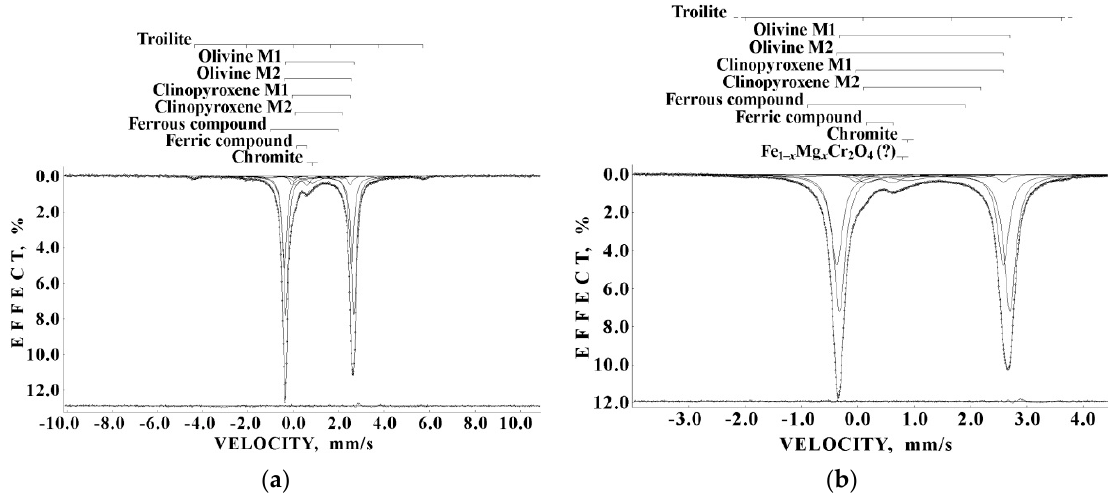
Figure 8. Mössbauer spectra of the stony part of Seymchan main group pallasite measured in: ( a ) large velocity range; and ( b ) small velocity range. Indicated components are the results of the best fits. The differential spectra are shown below. T = 295 K. Adopted from [15].